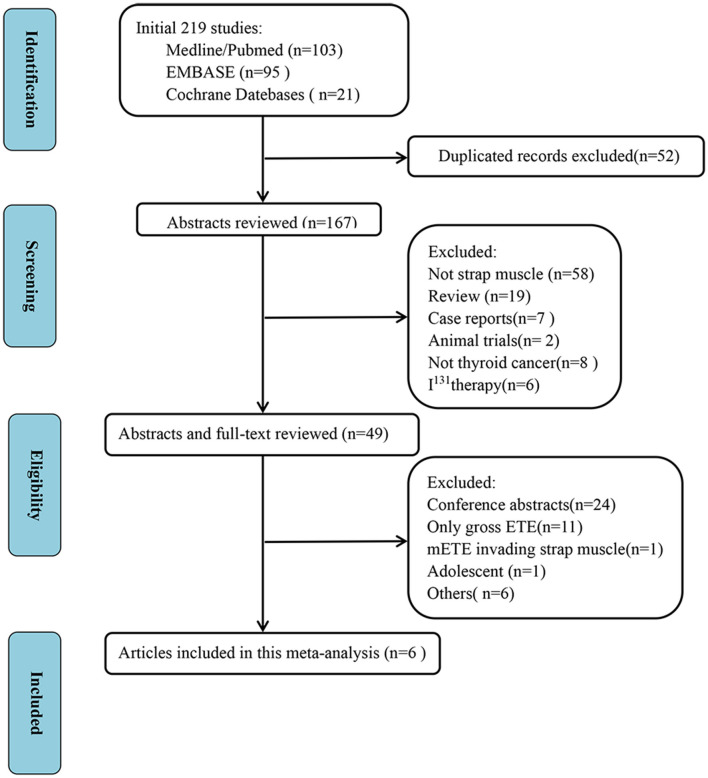
Selection process of studies in meta-analysis.